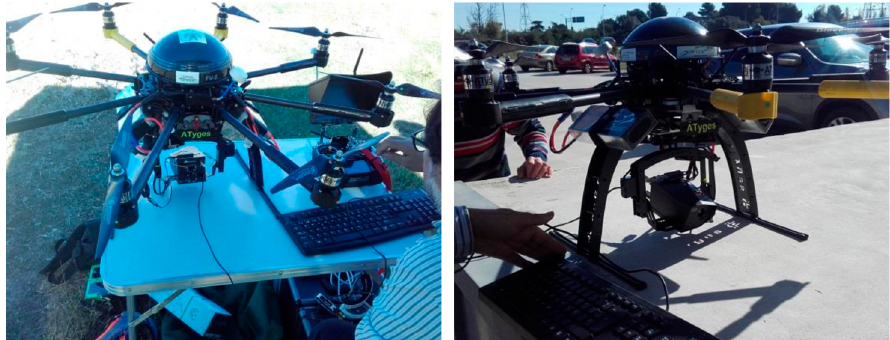
Figure 1. Images of the drone used for the aerial IR thermographic